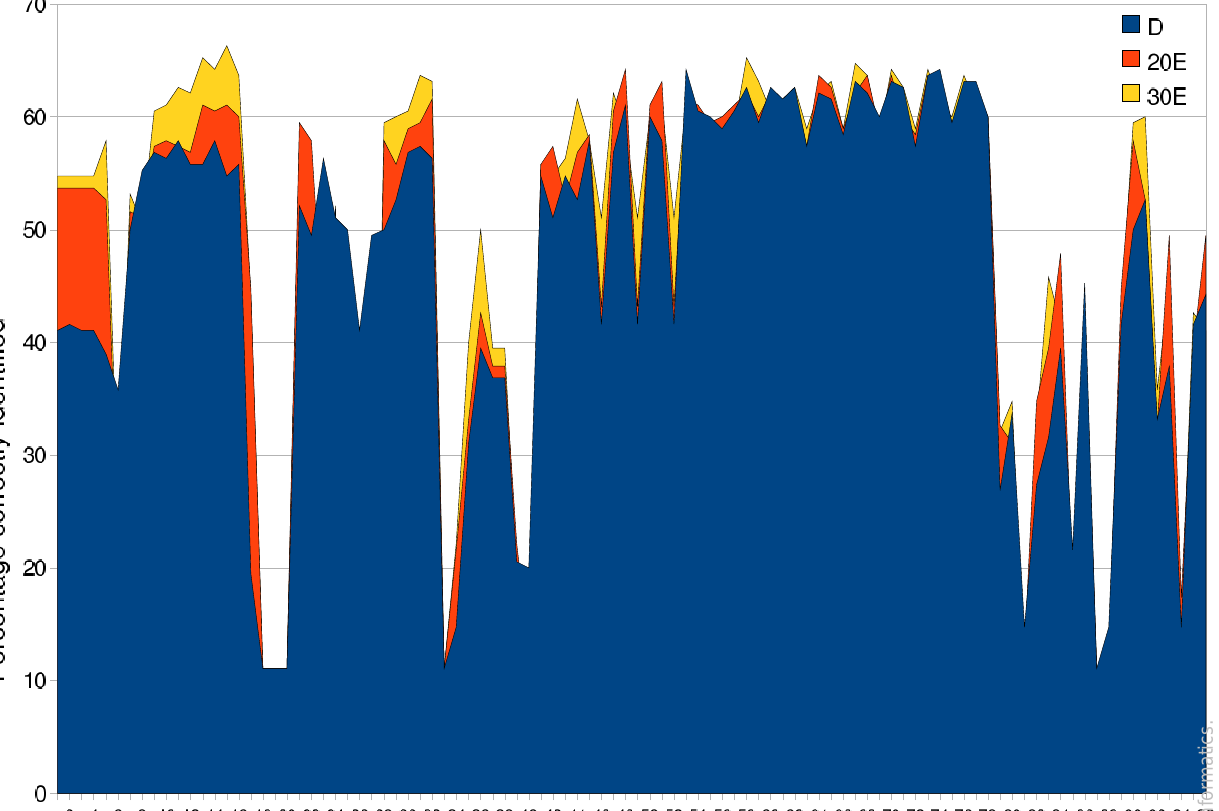
Figure 1: Plot showing the performance of each of the 96 classifier configurations on the dataset of